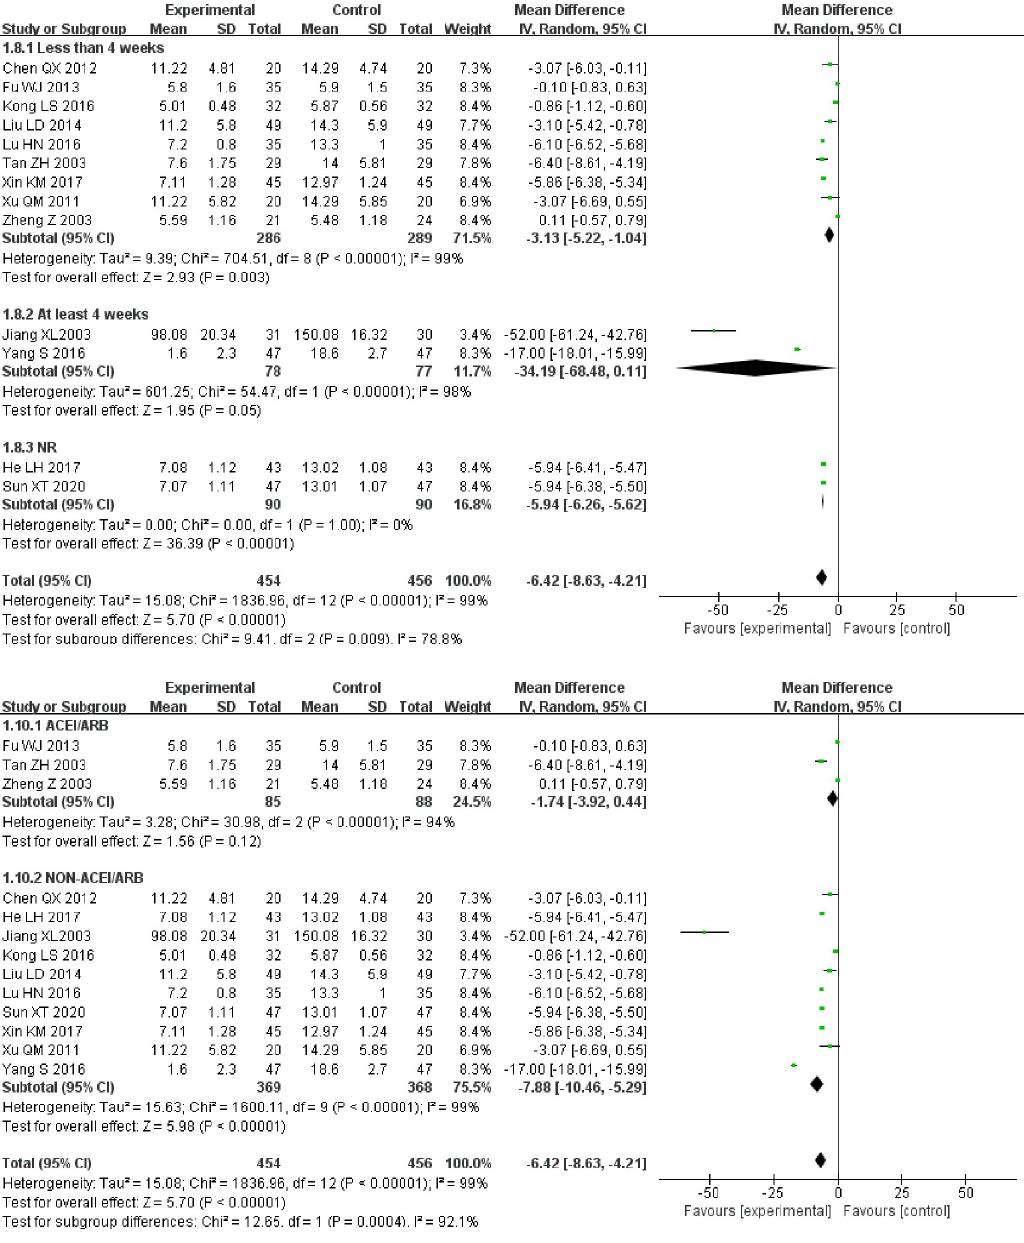
Fig 10. A. Forest plot of BUN subgroup analysis based on treatment duration. B. Forest plot of BUN subgroup analysis based on treatment